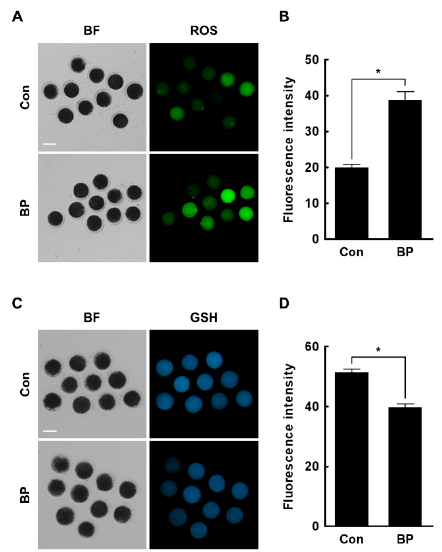
Figure 3. Effects of butylparaben (BP) exposure during in vitro maturation (IVM) on intracellular reactive oxygen species (ROS) and glutathione (GSH) levels. ( A ) Fluorescence images of oocytes treated with CM-H2DCFDA for measurement of intracellular ROS levels in the BP-treated and control groups. Bar = 100 um. ( B ) Quantification of the fluorescence intensity in the BP-treated and control groups (Con; n = 50, BP; n = 50). ( C ) Fluorescence images of oocytes treated with CMF2HC for measurement of the intracellular GSH level in the BP-treated and control groups. Bar = 100 um. ( D ) Quantification of the fluorescence intensity in the BP-treated and control groups (Con; n = 50, BP; n = 50). The data are from three independent experiments and the values represent the mean ± SEM. * p < 0.05.